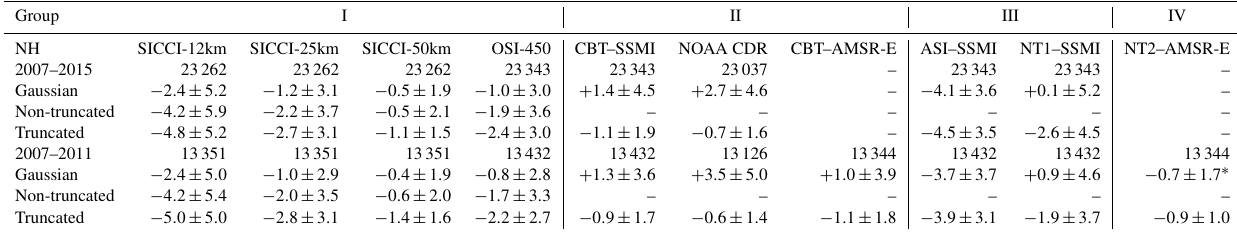
Table 3. Inter-comparison results to near-100% SIC (RRDP2) for the Arctic (see Fig. 14a). The rows “Gaussian” show the mean difference of the modal value of Gaussian fit to satellite SIC ≤ 99% (compare Fig. 3) minus near-100% reference SIC (RRDP2 SIC) ± 1 sigma of the Gaussian fit (see Fig. 14a). The rows “Non-truncated” show the mean difference satellite SIC minus RRDP2 SIC ± 1 standard deviation of the difference for SICCI and OSI-450 products. The rows “Truncated” show the mean difference of satellite SIC constrained to a maximum value of 100% minus RRDP2 SIC ± 1 standard deviation of the difference. All values in these rows are given in percent sea-ice concentration. Values in rows denoting the periods 2007–2015 and 2007–2011 contain the number of valid data pairs. See text for meaning of ∗ in the column